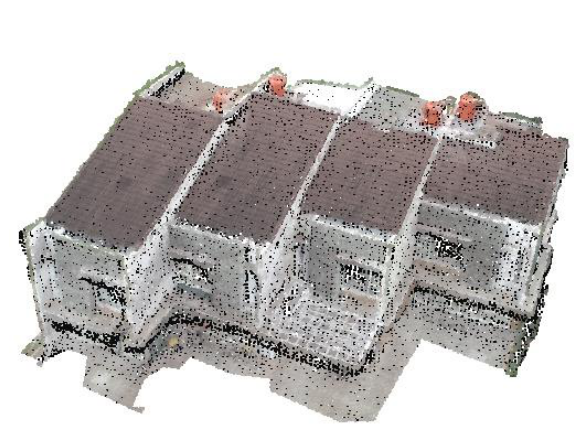
Figure 8. The result of Dense Point Cloud generation with MVS